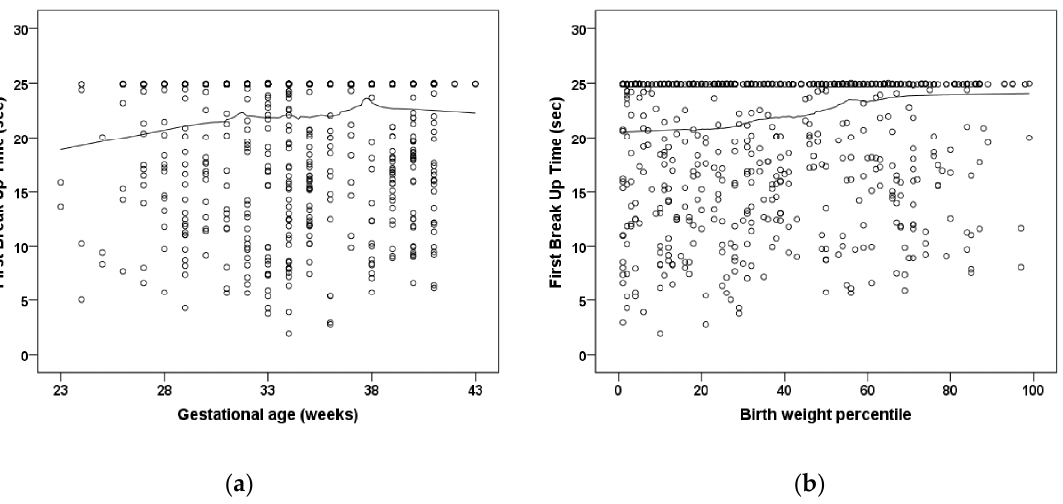
Figure 1. Relationship of ( a ) gestational age and ( b ) birth weight percentile to the first break-up time (sec.) in the Gutenberg Prematurity Eye Study. Figure legend 1: There is no significant association between low gestational age and low birth weight percentile with first break-up time. The line pre- sents the Loess (Locally Weighted Scatterplot Smoothing) curve.